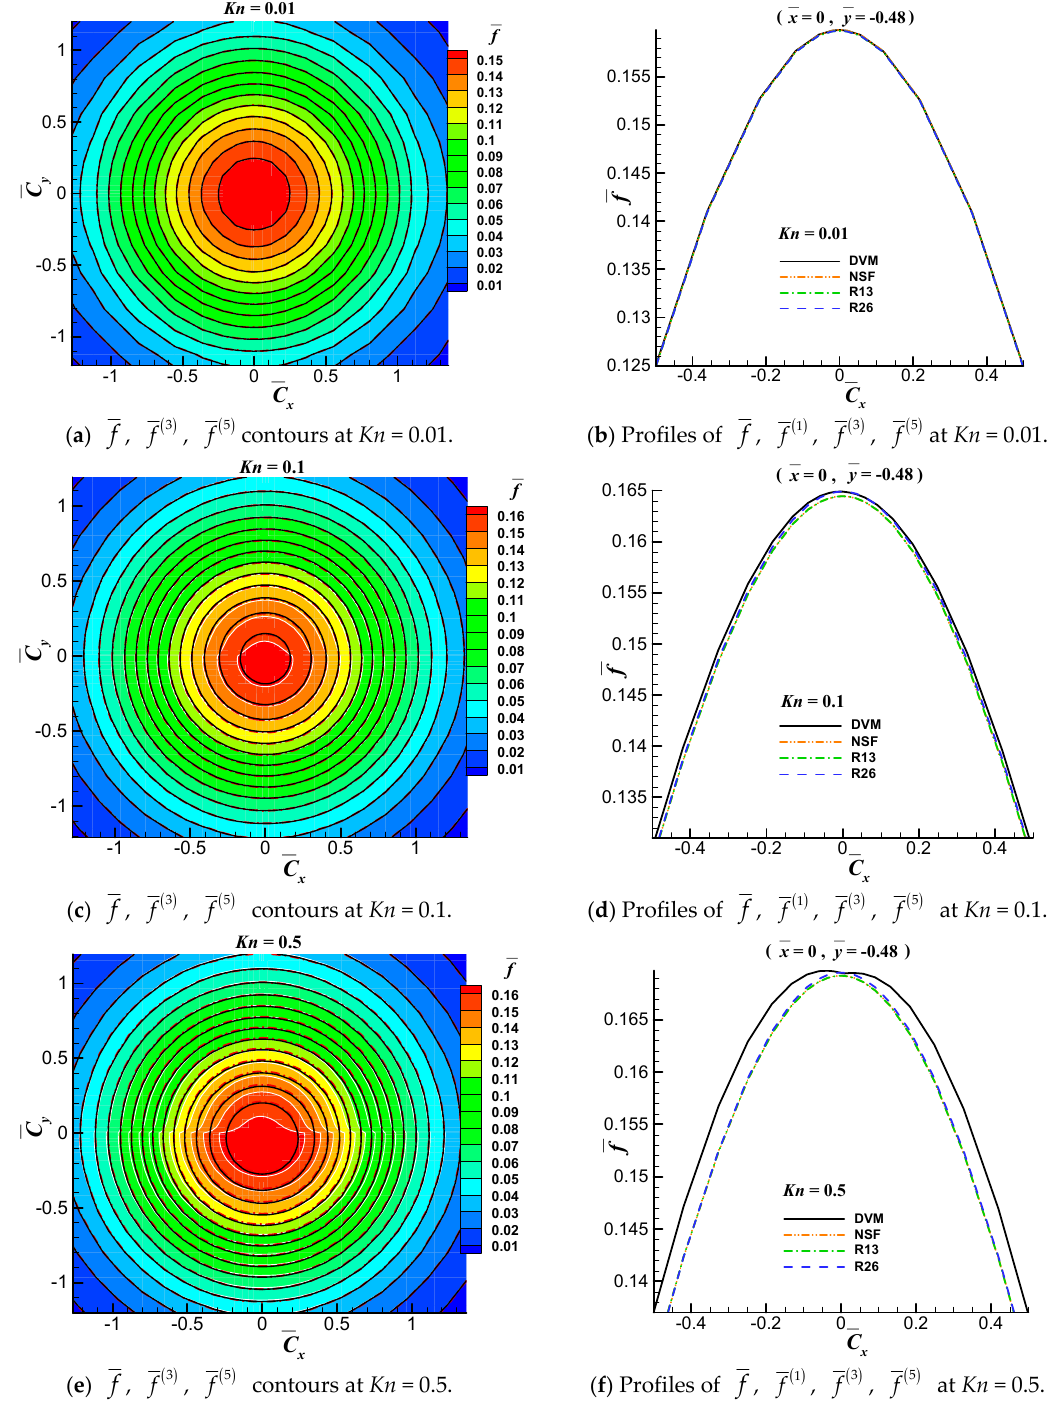
Figure 15. Comparison of the VDFs at ( a , b ): Kn = 0.01; ( c , d ): Kn = 0.1; ( e , f ): Kn = 0.5. Left panel the figure, contours and white lines: f ; black lines: . The remaining notations have been defined in Figure 2.